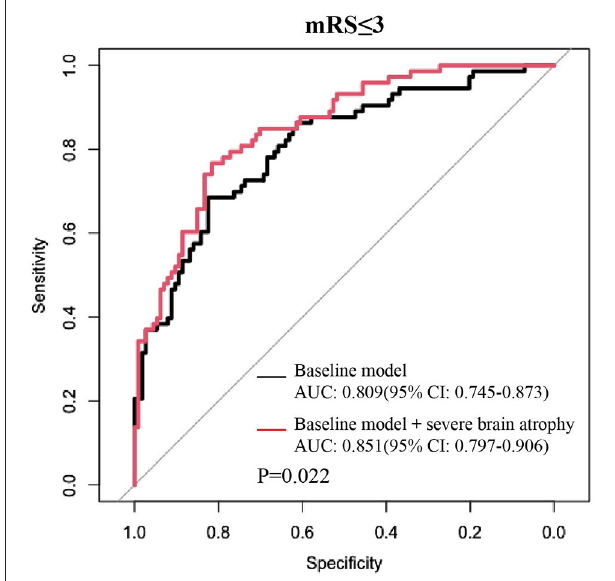
FIGURE 3 | Adding severe brain atrophy index into the baseline model obviously increased its discrimination ability in predicting favorable outcomes among patients with a satisfied reperfusion level (mTICI ≥ 2b). Baseline model: multivariable logistic model constructed by age, sex, dyslipidemia, atrial fibrillation, baseline NIHSS score, baseline PC-ASPECTS, mTICI, PC-CS, and onset to recanalization